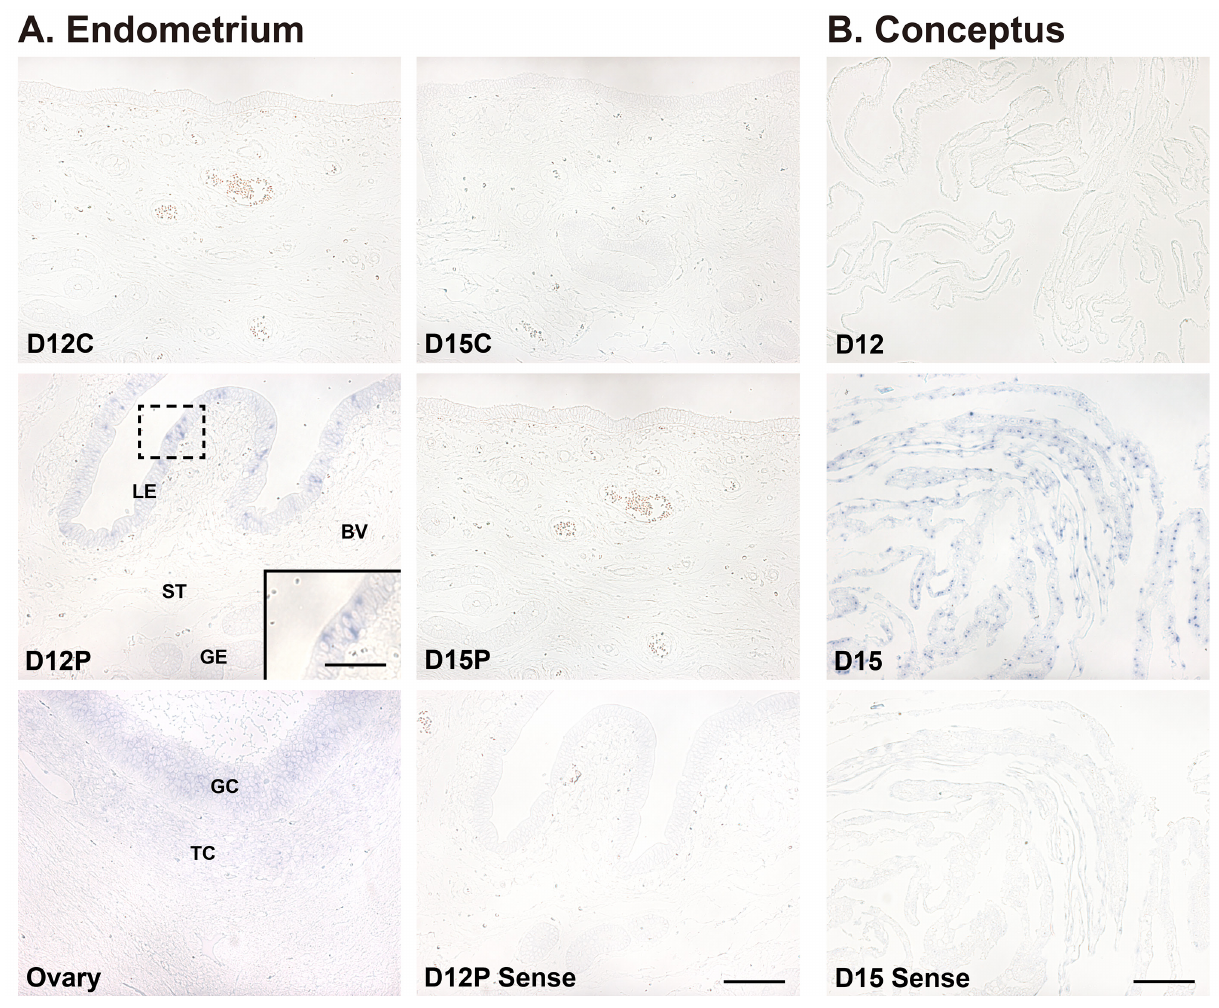
Figure 3. In situ hybridization analysis of serum amyloid A3 ( SAA3 ) expression in the endometrium (A) and conceptus tissues (B). (A) Representa- tive images on days 12 and 15 of the estrous cycle and pregnancy are shown. A uterine section from day 12 of pregnancy hybridized with DIG-la- beled sense SAA3 cDNA probe (Sense) is shown as the negative control, and a tissue section from the ovary served as a positive control. D, day; C, estrous cycle; P, pregnancy; LE, luminal epithelium; GE, glandular epithelium; ST, stroma; BV, blood vessel, GC, granulosa cell; TC, theca cell. Bars = 100 µm and 20 µm in inset. (B) In situ hybridization analysis of SAA3 mRNA in conceptus tissues on days 12 and 15 of pregnancy. A conceptus tissue section from day 15 of pregnancy hybridized with DIG-labeled sense SAA3 cDNA probe (Sense) was the negative control. D, day; P, preg- nancy. Bar = 100